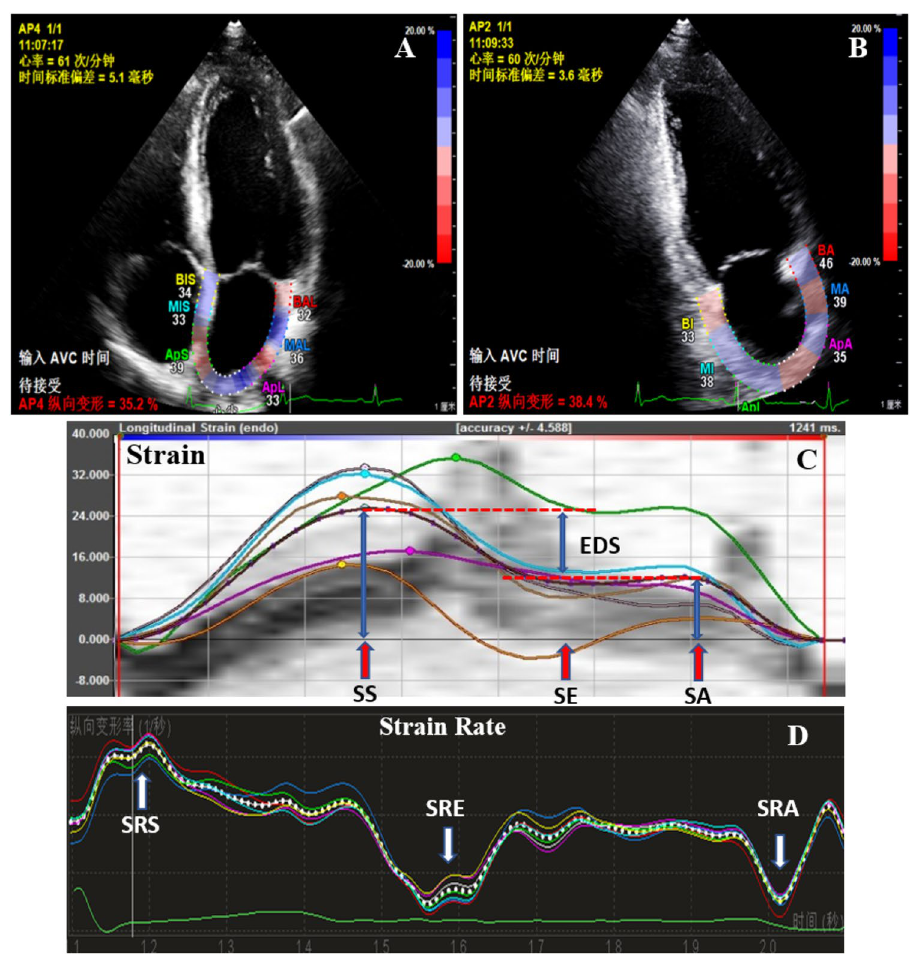
Figure 1. ( A ) Apical 4 chamber view; ( B ) Apical 2 chamber view; ( C ) Strain curve: The longitudinal LA strain curve had a positive systolic peak (SS), an early diastolic plateau (SE), and a late diastolic peak (SA); ( D ) Strain rate curve: the longitudinal LA strain rate curve had a positive systolic peak (SRS), an early negative peak at early diastole (SRE), and a late negative peak at late diastole (SRA). SS and SRS represented the LA reservoir function, EDS (= SS − SA) and SRE reflected the LA conduit, and SA and SRA were the indices of the LA booster function.